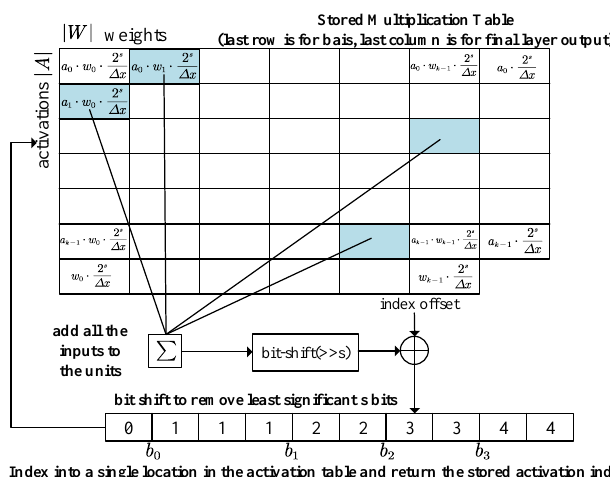
Figure 6. Using a stored multiplication table to avoid multiplication [36]. Calculations are trans- formed into search operations, which obviously reduces